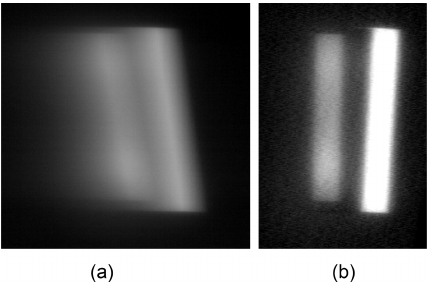
Figure 11. Infrared image of two plates moving with a speed of 1.5ms − 1 (a) ; after deblurring the objects (b) , their shape and real temperature are well